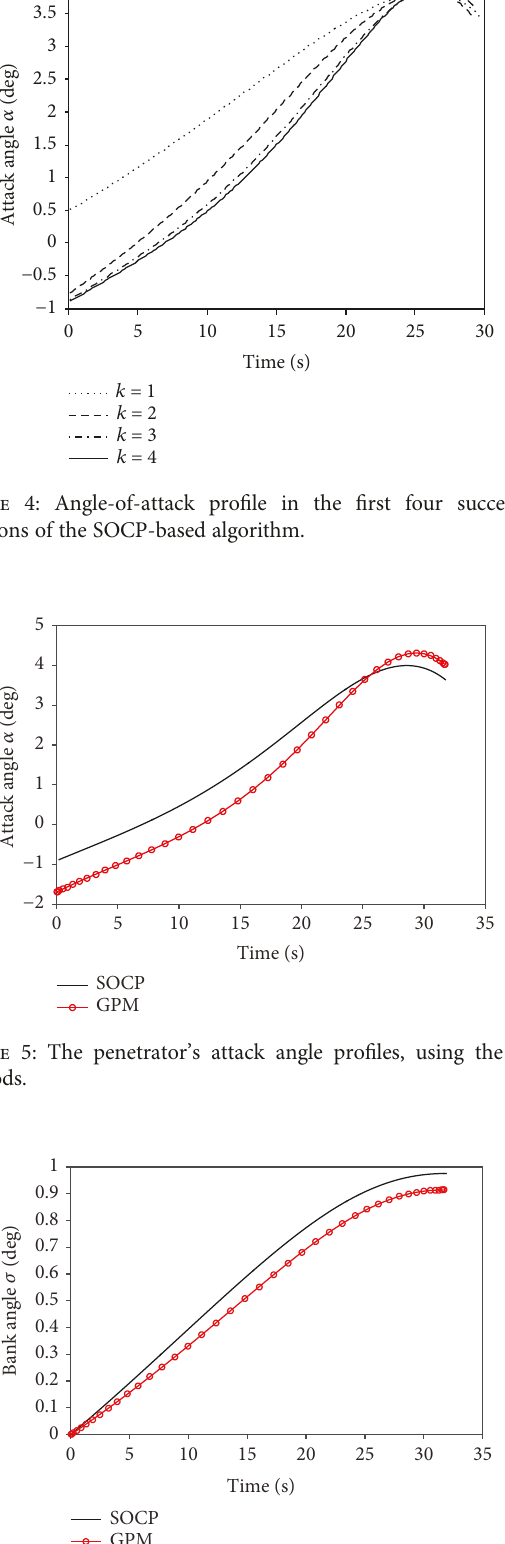
Table 1: The vehicle ’ s basic parameters [8].